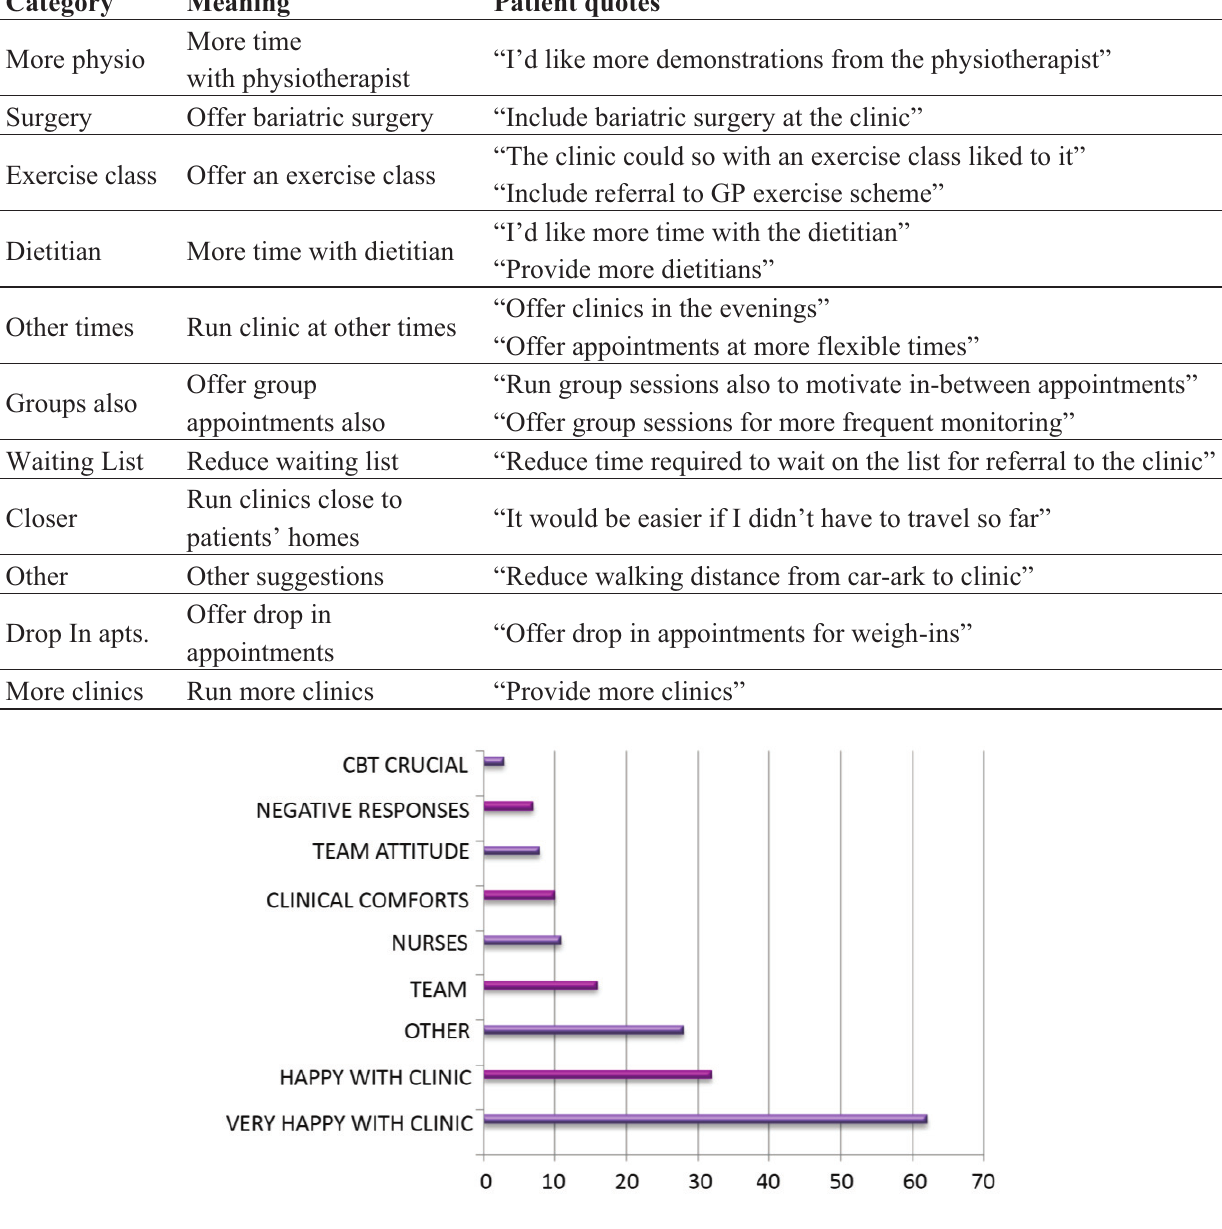
Figure 10. Number times each comment was made. Table 20. Number of times each comment was